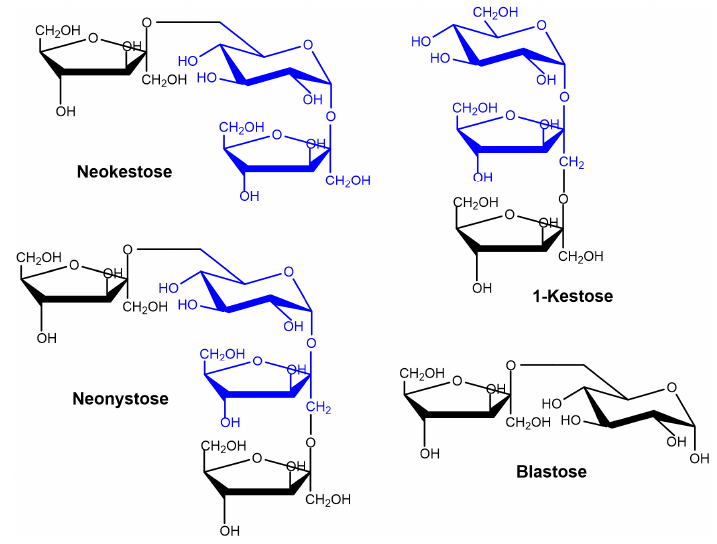
Figure 4. Structure of the FOS synthesized by immobilized pXd-INV. The sucrose skeleton is represented in blue.